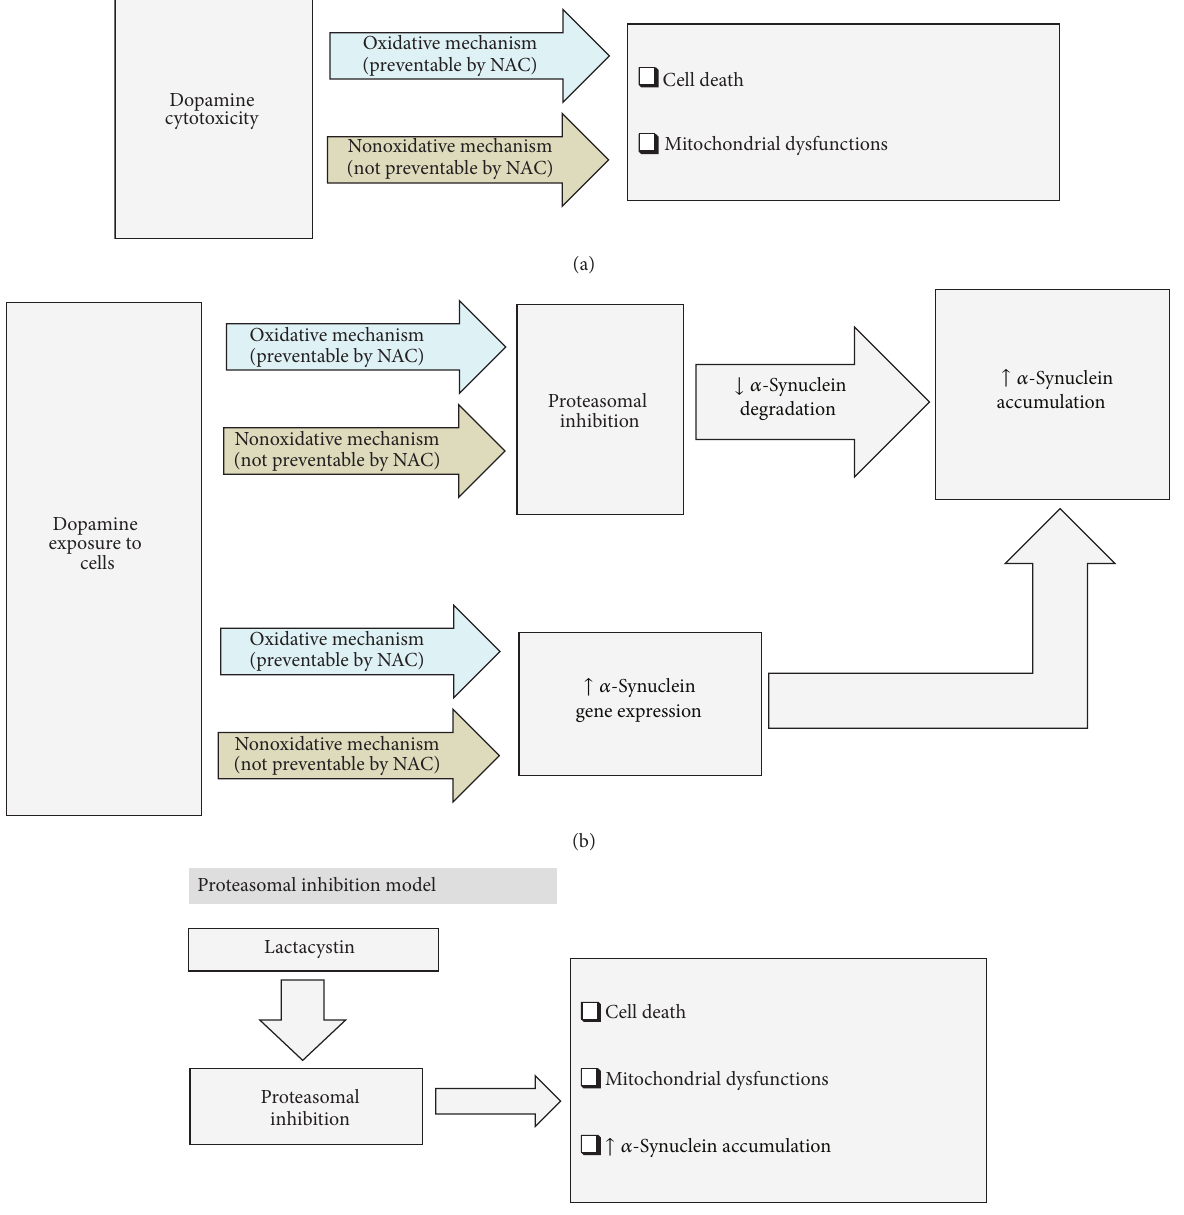
Figure 9: Probable mechanisms of dopamine cytotoxicity in SH-SY5Y cells: involvement of alpha-synuclein and proteasomal inhibition. (a) shows that dopamine causes cell death and mitochondrial dysfunctions involving both the oxidative (NAC responsive) and nonoxidative (NAC nonresponsive) mechanisms. (b) shows that dopamine causes proteasomal inhibition and increased alpha-synuclein gene expression involving similar kind of oxidative (NAC responsive) and nonoxidative (NAC nonresponsive) mechanisms. Both of these effects cause increased intracellular accumulation of alpha-synuclein. (c) shows our “proteasomal inhibition model” using lactacystin resulting in cell death, mitochondrial dysfunctions, and increased intracellular alpha-synuclein